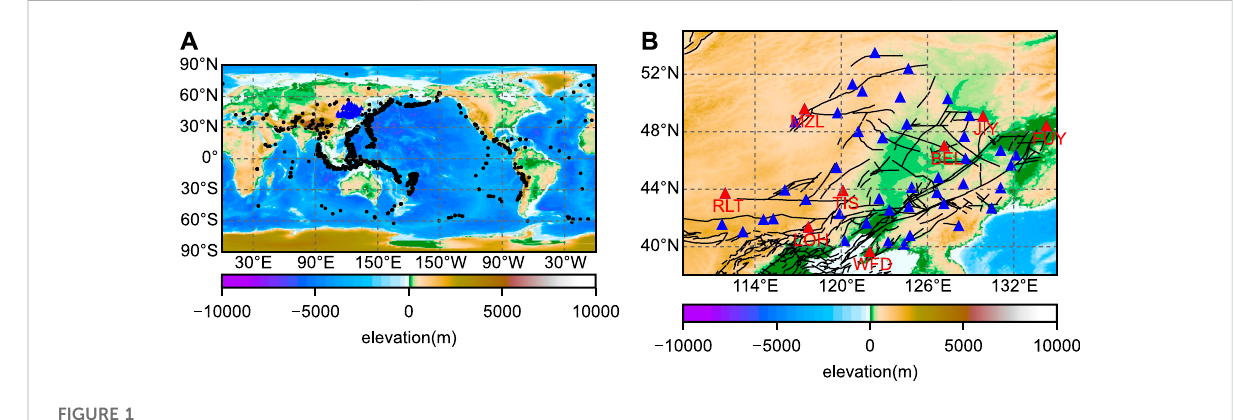
FIGURE 1 (A) Aglobalmapshowingthedistributionsofearthquakes(blackdots)andstations(bluetriangles)usedinTianetal.(2017). (B) Aregionalmapof Northeast China with triangles showing the stations ’ distribution, and the red ones are the stations taken as examples